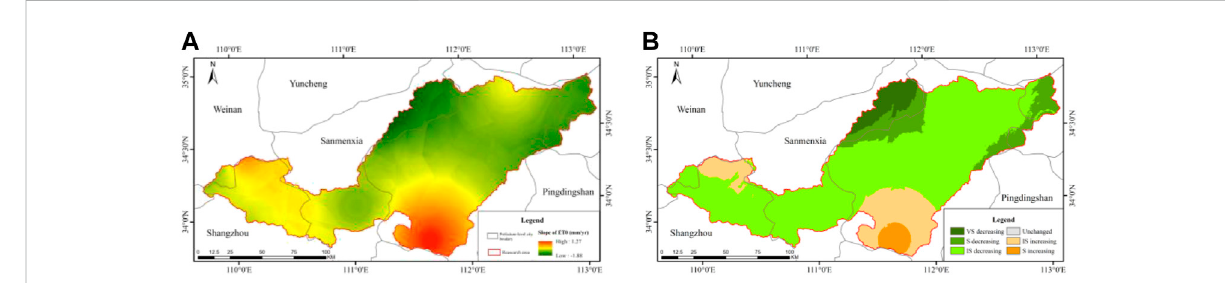
FIGURE 4 Slope of the ET 0 on the spatial scale: (A) slopes of ET 0 ; (B) signi fi cance levels of ET 0